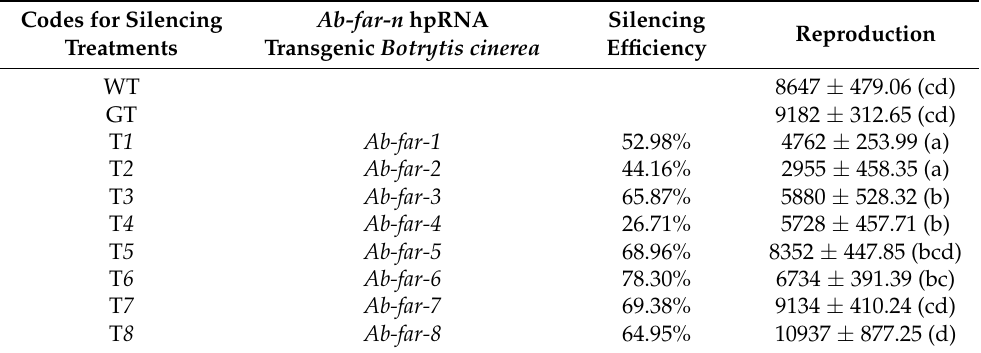
Table 2. Ab-far-n silencing efficiency and reproduction of Aphelenchoides besseyi fed Ab-far-n hpRNA transgenic Botrytis cinerea for 28